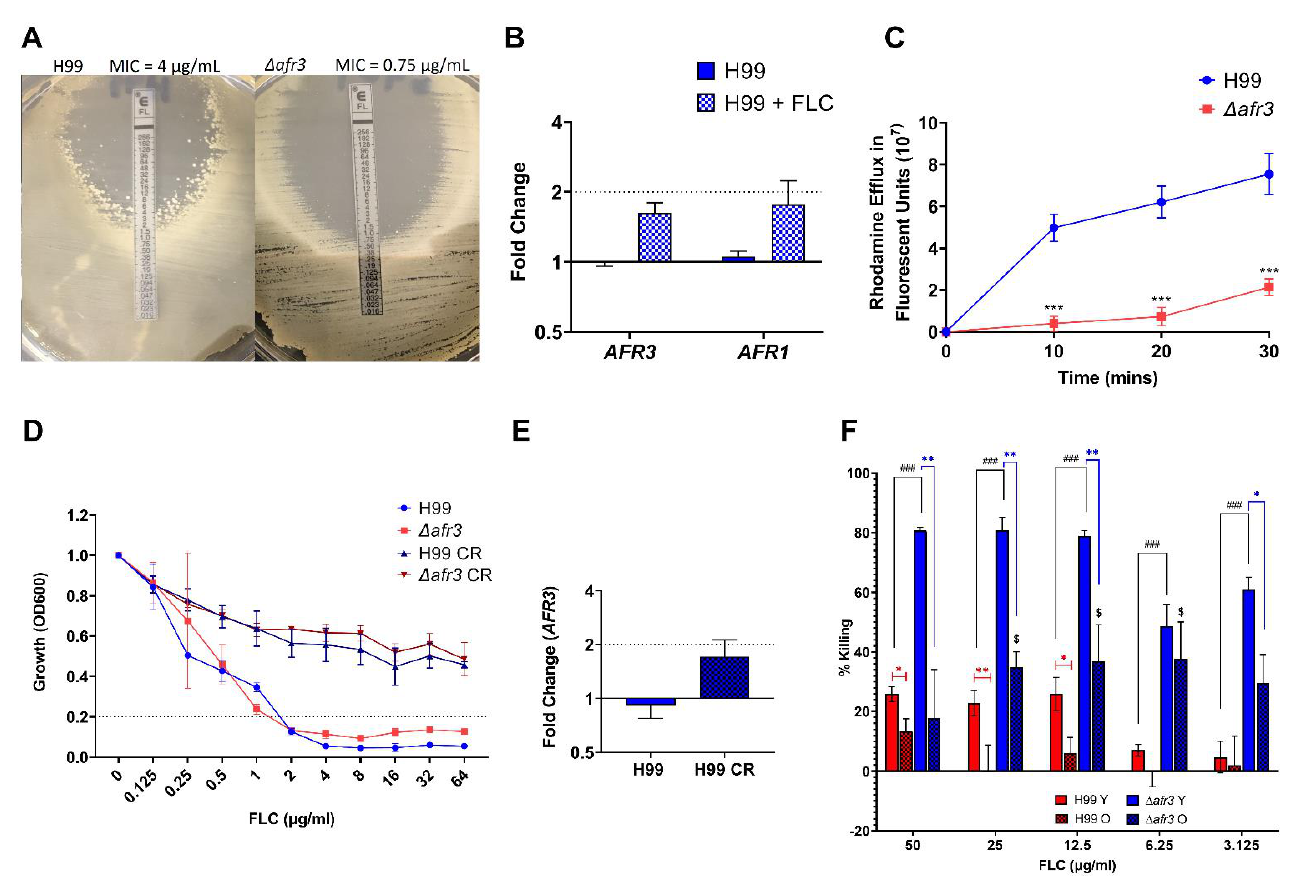
Figure 2. Afr3 is an Important Pump for Drug Resistance. ( A ) C. neoformans ∆ afr3 is more sensitive to FLC than H99 in an FLC E-Test in a YPD plate; ( B ) H99 cells that underwent FLC treatment with 32 µ g/mL for 2 h (checkered blue/white bar) do not increase expression of AFR3 and AFR1 compared to H99 wild-type (blue bar); ( C ) ∆ afr3 (red line) decreases efflux compared to H99 (blue line) in a Rhodamine 6G assay. Statistical analysis was performed with multiple unpaired Student’s t -test, *** p < 0.001; ( D ) FLC tolerance observed under CR conditions (SM 0.05% glucose) (H99 CR: dark blue line, ∆ afr3 CR: dark red line) is independent of Afr3 presence, as shown by the susceptibility under normal conditions (SM 2% glucose) (H99: blue line, ∆ afr3: red line); ( E ) expression of AFR3 is not increased under CR conditions (checkered blue bar) when compared to normal glucose conditions (blue bar); ( F ) the ∆ afr3 young cells ( ∆ afr3 Y, blue bar) are more susceptible to FLC killing than H99 young cells (H99 Y, red bar). Furthermore, ∆ afr3 old cells ( ∆ afr3 O, checkered blue bar) lose FLC killing tolerance when compared to H99 old cells (H99 O, checkered red bar). Statistical analysis was performed with multiple unpaired Student’s t -test, * p < 0.05, ** p < 0.01, ### p < 0.001, and $ p < 0.05; error bars represent the standard deviation between biological